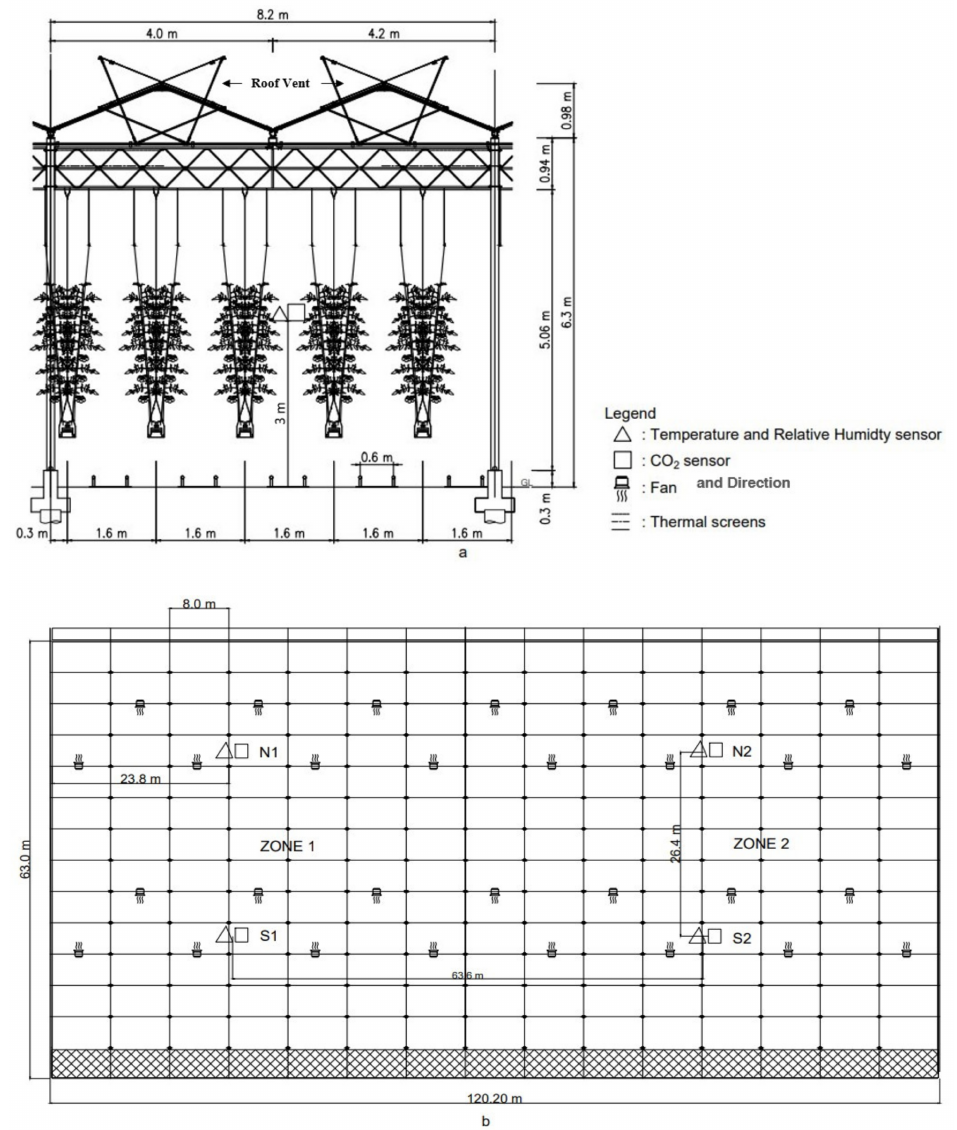
Figure 3. Greenhouse dimensions and positions of sensors in the MSG experimental greenhouse: ( a ) vertical view and ( b ) horizontal